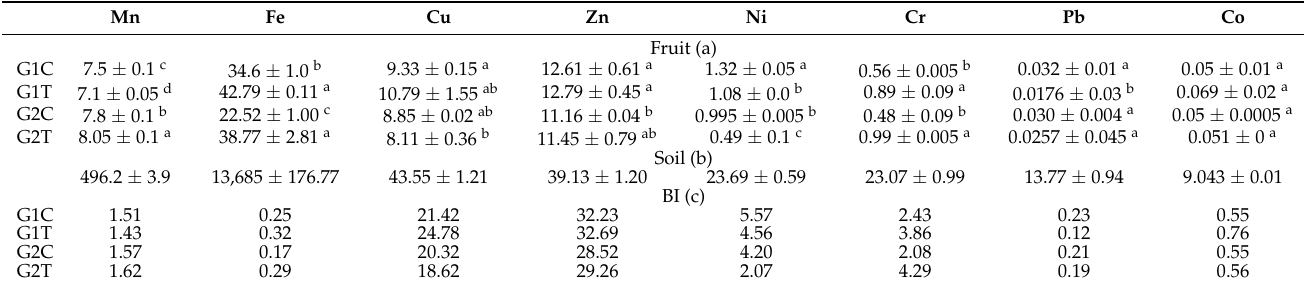
Means with the same letter in the same column are not significantly different from each other according to Tukey’s test ( p < 0.05). Error lines represent ± standard deviation of the mean. Different letters ( a,b,c,d ) indicate statistically significant differences according to Tukey’s test ( p <